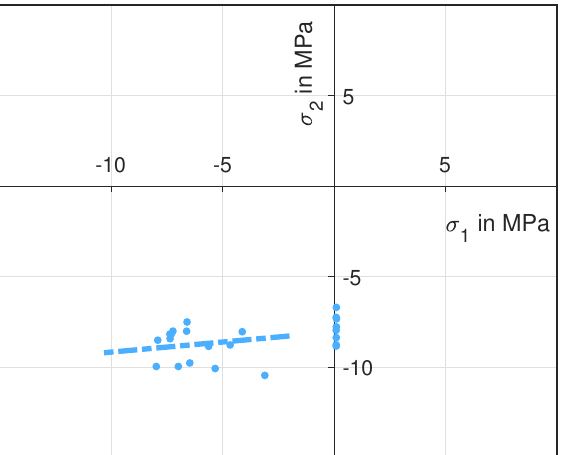
Figure 9. Test results of the uni- and bi-axial compression tests. The dashed line is a linear best fit to the test results.